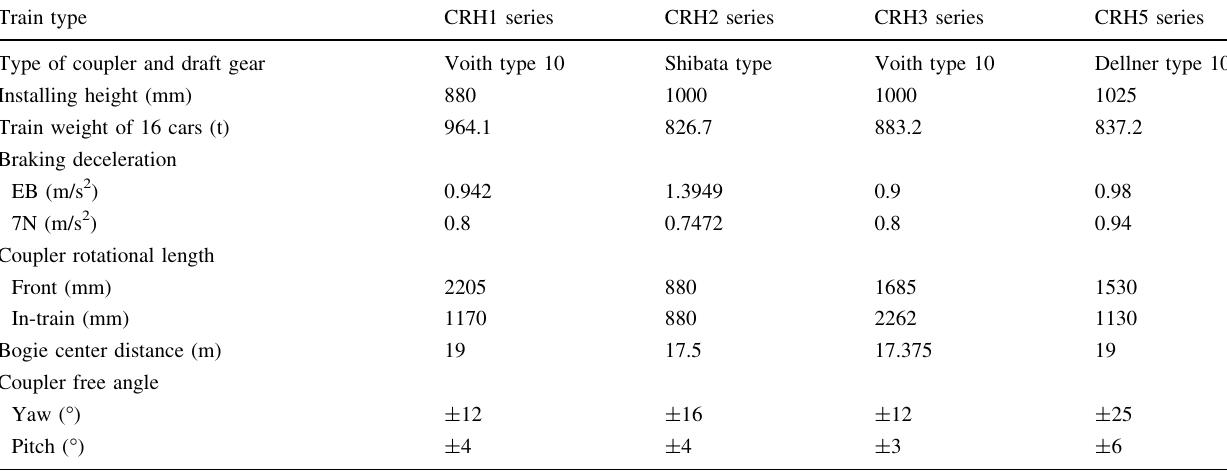
Table 1 Technological parameters of train and coupler system for CRH series EMUs Train